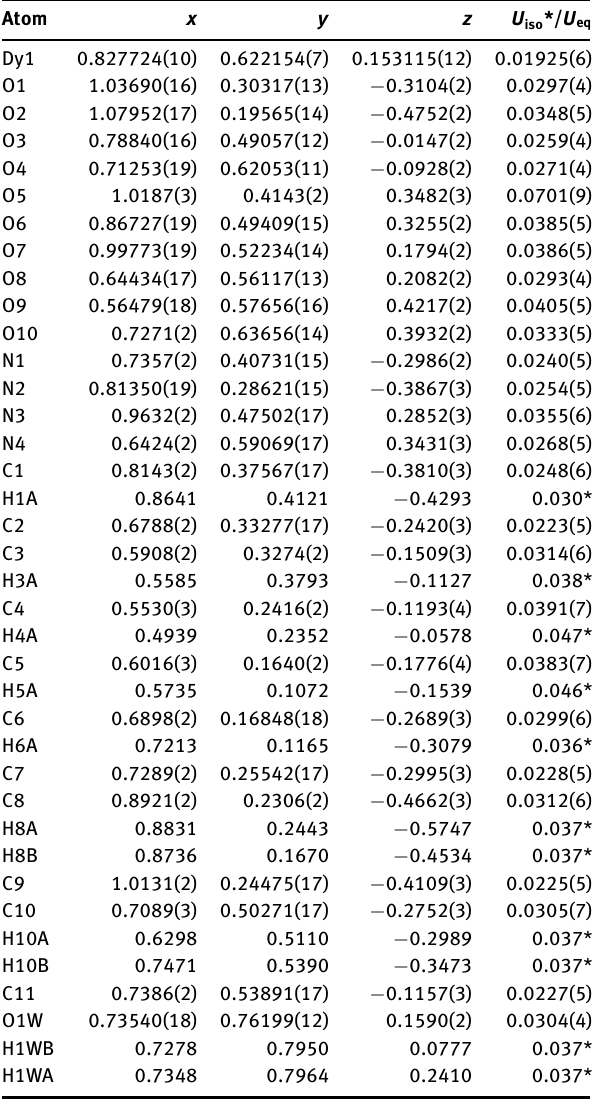
Table 2: Fractional atomic coordinates and isotropic or equivalent isotropic displacement parameters (Å 2